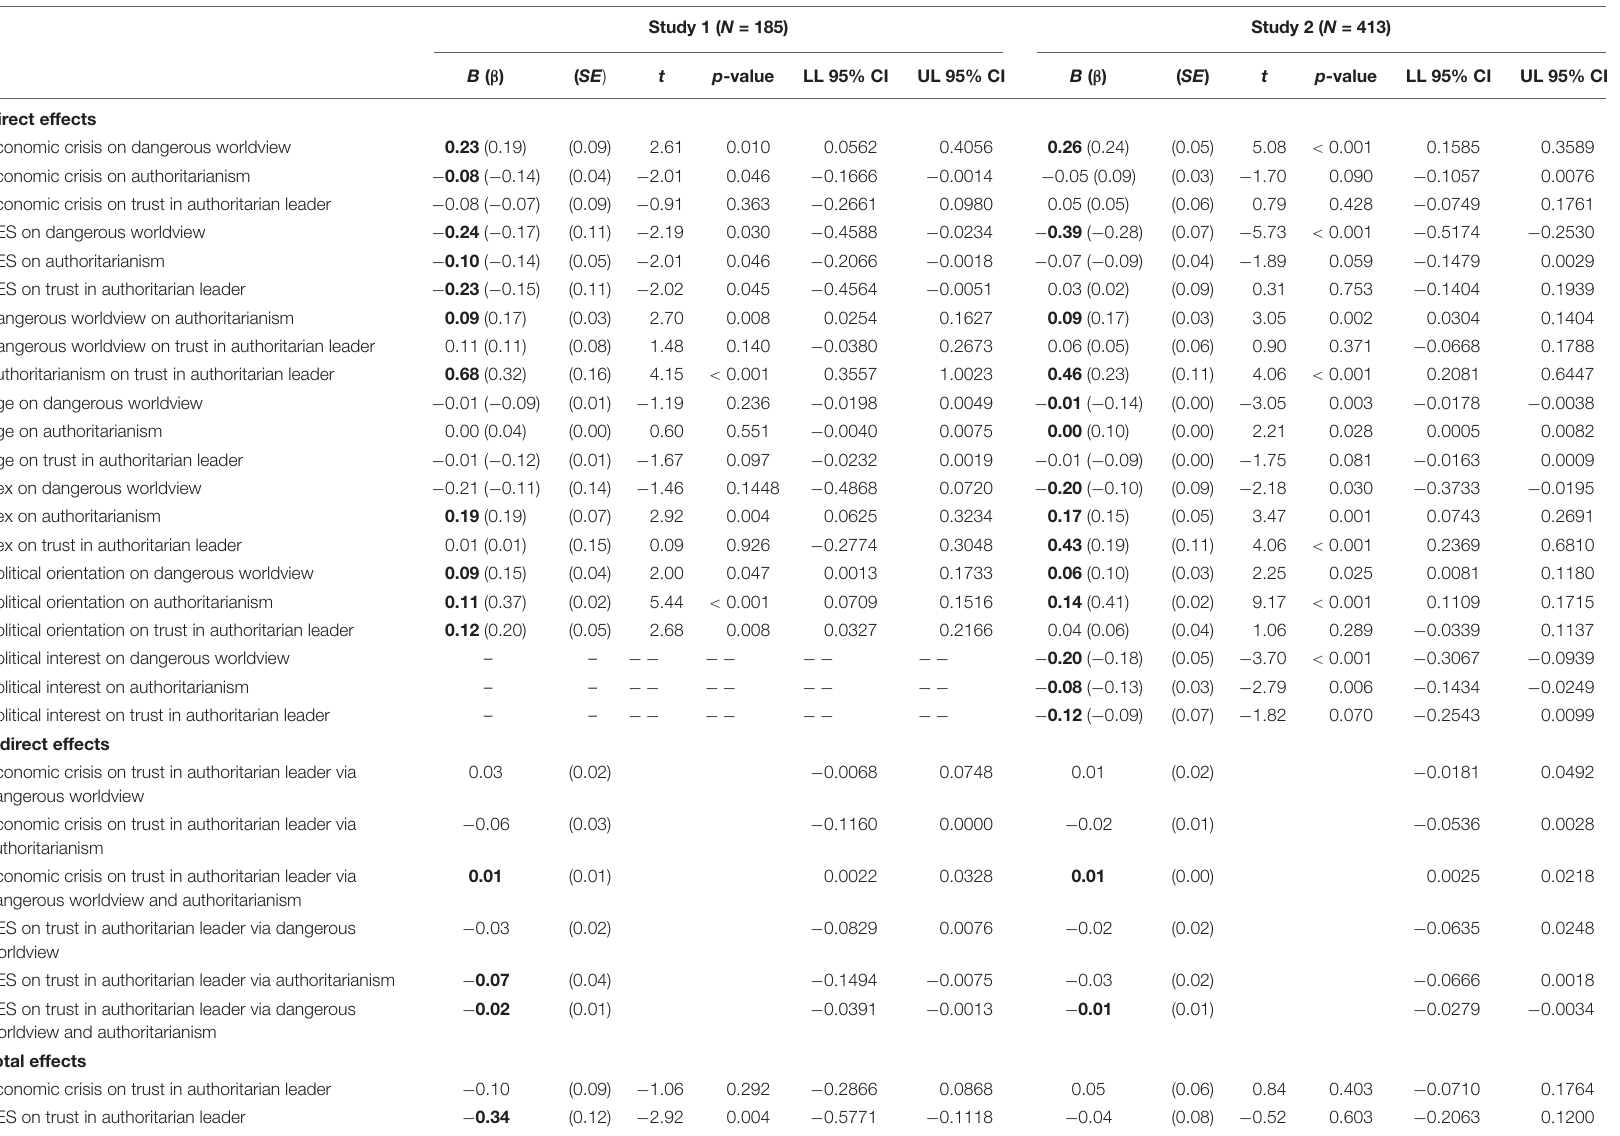
TABLE 3 | Direct, indirect and total effect of threat by economic crisis and SES on trust in an authoritarian political leader including both predictors in the analysis and controlling by age, sex, political orientation (Studies 1 and 2) and political interest (Study 2). Study 1 ( N = 185) Study 2 ( N =